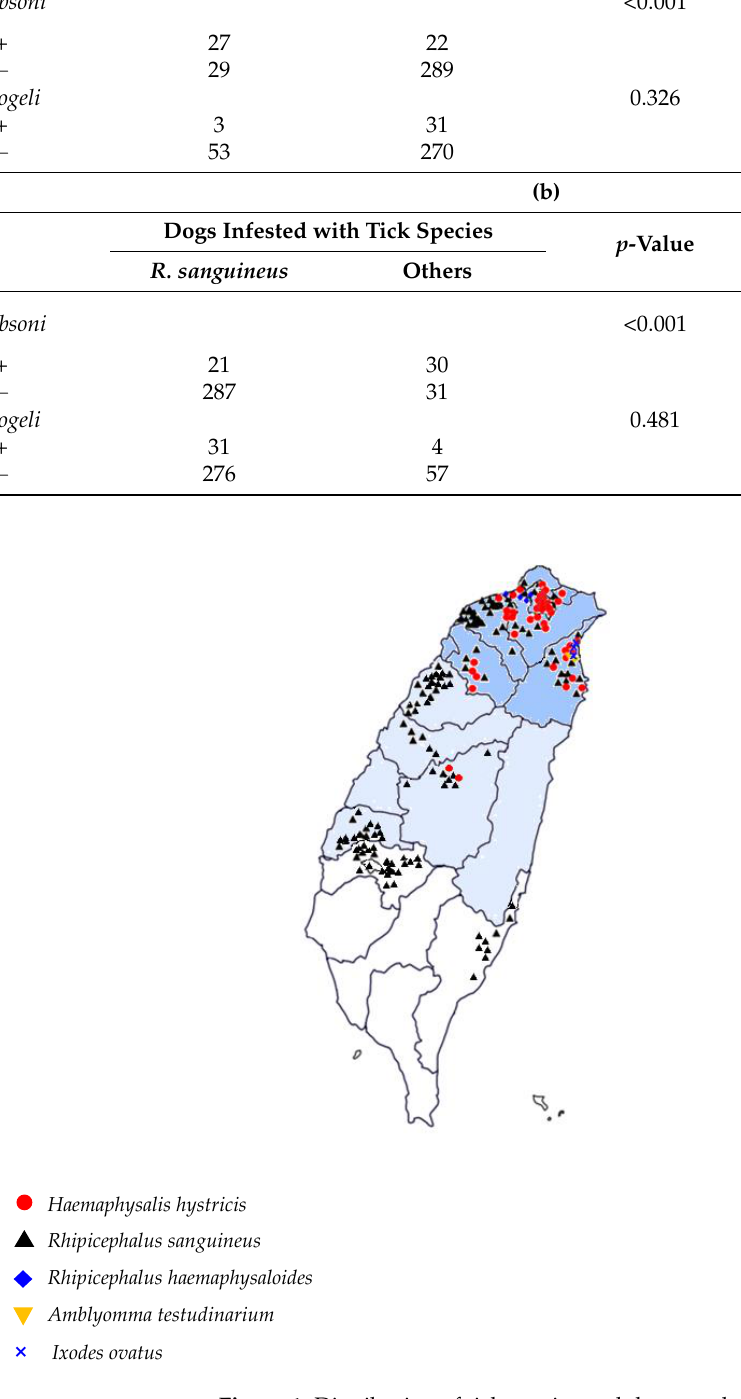
Table 2. ( a ) The infection rate of Babesia spp. in dogs infested with H. hystricis and other tick species. ( b ) The infection rate of Babesia spp. in dogs infested with R. sanguineus and other tick species. (a) Dogs Infested with Tick Species p -Value